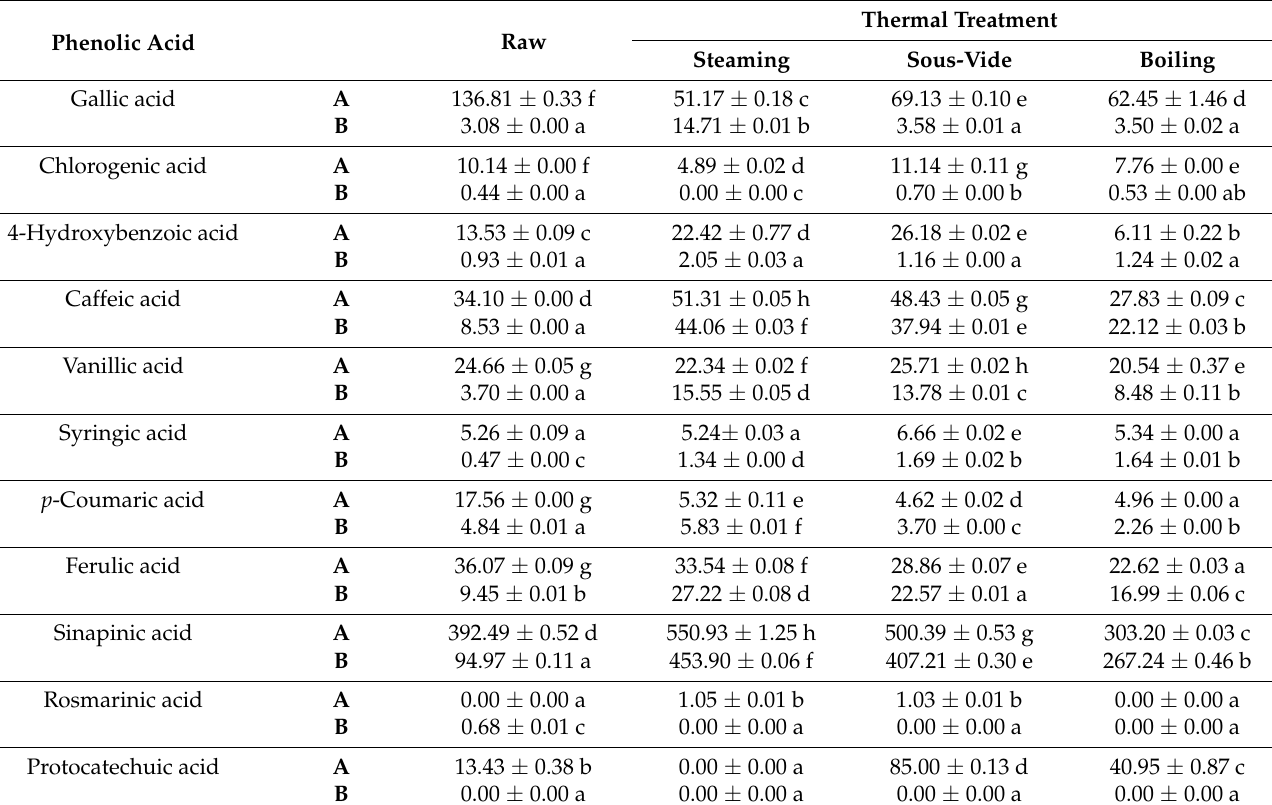
Table 1. Phenolic acids concentration (mg/kg f.m.) in raw and thermally-treated Brussels sprouts before and after in vitro